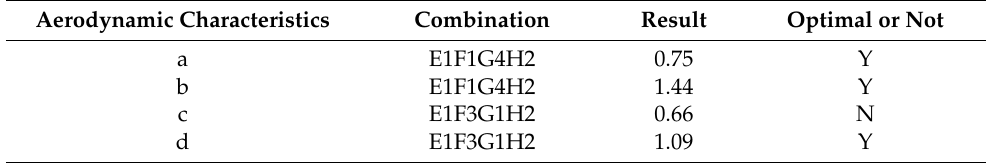
Figure 16. The duct’s normalized K value curve. ( a ) Hover flight. ( b ) Forward flight. After the sample calculation and the optimization of K values, the expected optimal value is also reached except for the forward flight efficiency as shown in Table 9. Table 9. Validation of duct’s optimal sample